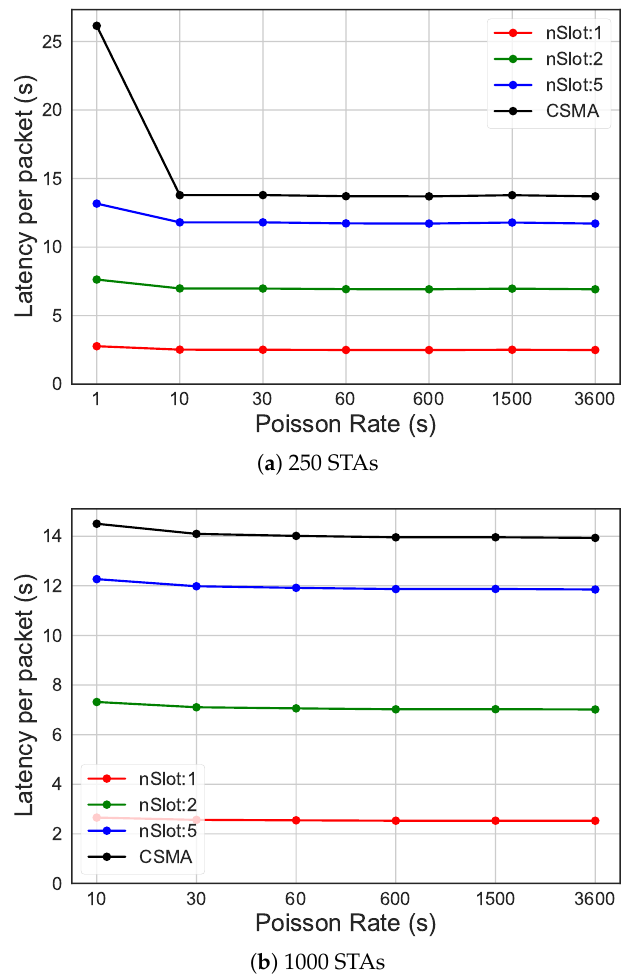
Figure 11. Latency of different traffic rates, comparing CSMA/CA and the usage of 10 RAW groups and one, two and five slots per